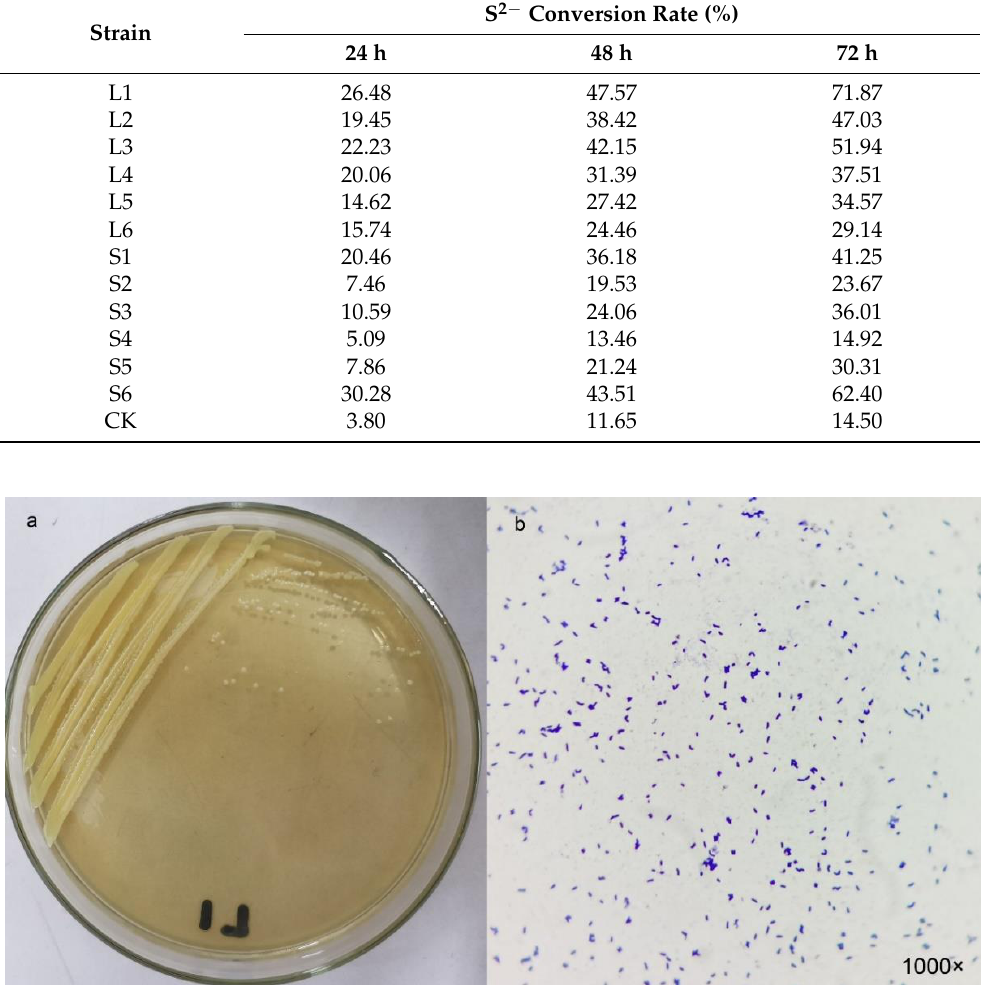
Figure 1. ( a ) Colony and ( b ) bacterial morphology after Gram stain of strain L1. Based on the gene sequence comparison, strain L1 showed the highest similarity to Cellulosimicrobium sp. (Figure 2), and the accession number (MZ687074) was submitted to GenBank. Previous studies showed that the Cellulosimicrobium sp. isolated from soil, marine sediment, and sewage can degrade 2,4,5-trichlorophenoxyacetic acid and biodiesel- oil [28–30]; however, studies on inorganic sulfur conversion are scarce. Therefore, further exploration was